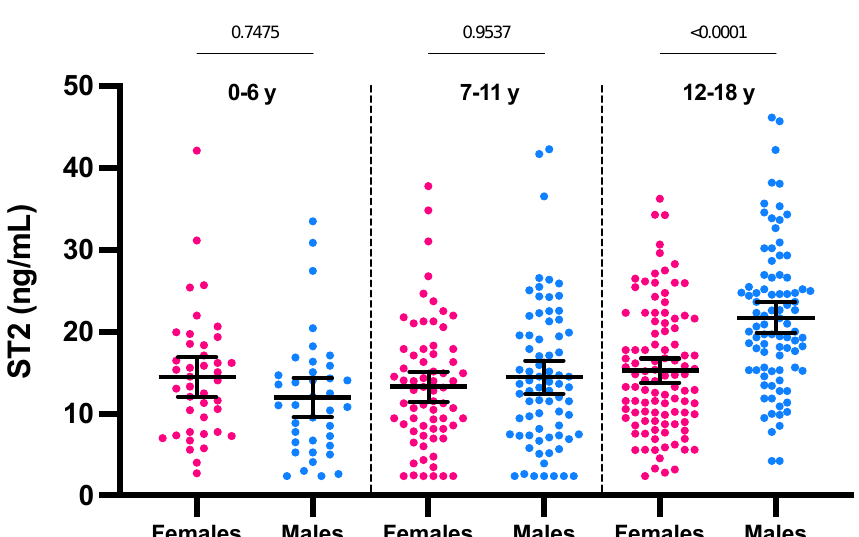
Figure 2. ST2 concentrations according to age partitions and sex. Mean and 95% CI of the mean are represented in black.